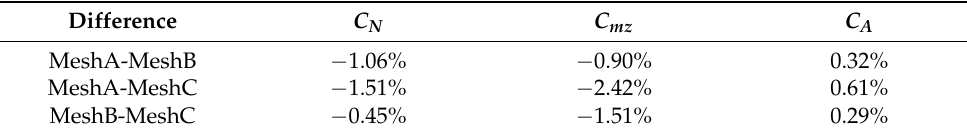
Table 3. Aerodynamic coefficients and relative differences.